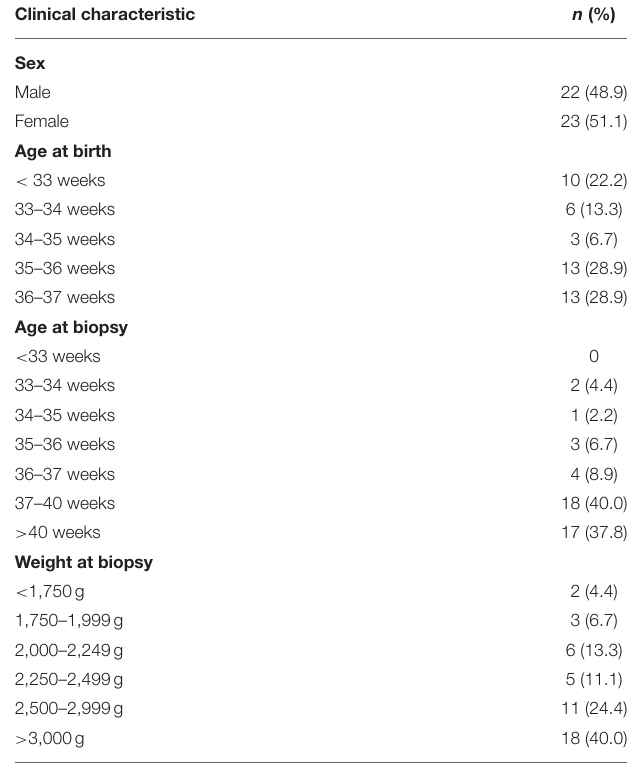
TABLE 1 | Patient